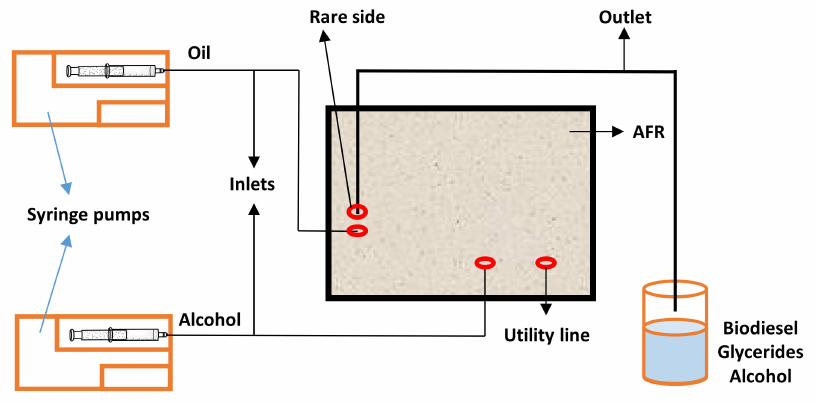
Figure 30. Advanced FlowTM Reactor (AFR).